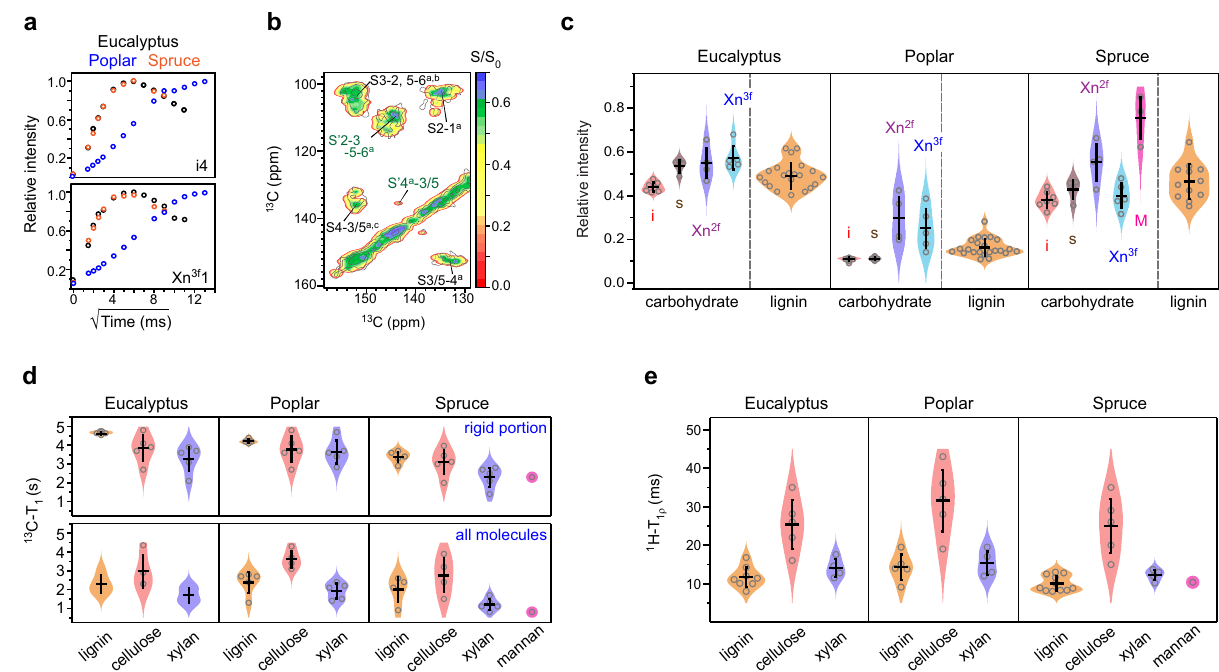
Fig. 4 Site-speci fi c hydration and dynamic landscape of biomolecules. a Representative water-to-biomolecule 1 H polarization transfer buildup curves. The data of interior cellulose carbon 4 (i4) and three-fold xylan carbon 1 (Xn 3f 1) are compared across plants. Poplar has slow buildup due to the limited water contact. b Hydration map on top of a 2D spectrum plotting the ratio (S/S 0 ) of water-edited intensity (S) to the equilibrium intensity (S 0 ). A larger S/S 0 ratio indicates better polymer hydration. c Distribution of the relative water-edited intensities (S/S 0 ) of polysaccharides and lignin in eucalyptus, poplar, and spruce. Molecules with better water retention show higher water-edited intensities. Poplar is poorly hydrated. Relative intensities: n = 7, 4, 4, and 5 for i, s, Xn 2 f , and Xn 3 f , respectively. For lignin, n = 21, 23, and 12 for eucalyptus, poplar and spruce, respectively. n = 3 for the mannan in spruce. Source data are provided as a Source Data fi le. d 13 C – T 1 relaxation times of rigid (blue rectangles) and all molecules (colored as yellow, red, purple, and magenta for different molecules) in three woody plants, which represent nanosecond-timescale motions. 13 C – T 1 relaxation time constants: n = 5 for both cellulose and xylan in all three plants. For lignin, n = 5, 4, and 5 for eucalyptus, poplar and spruce, respectively. Source data are provided as a Source Data fi le. e 1 H – T 1